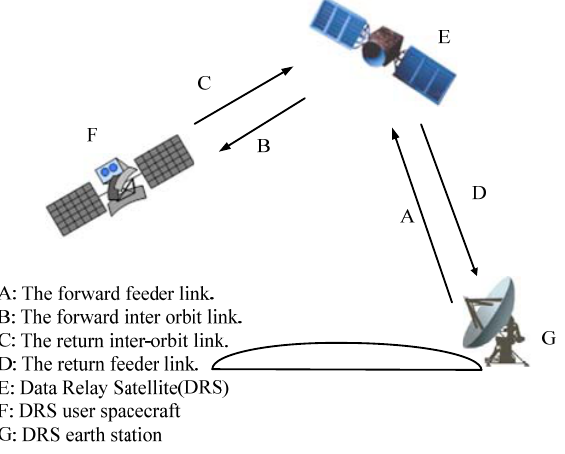
Fig. 1. Data relay satellite system